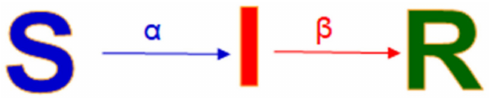
Figure 1. Schematic representation of the SIR model. The total size of the population N is given by: